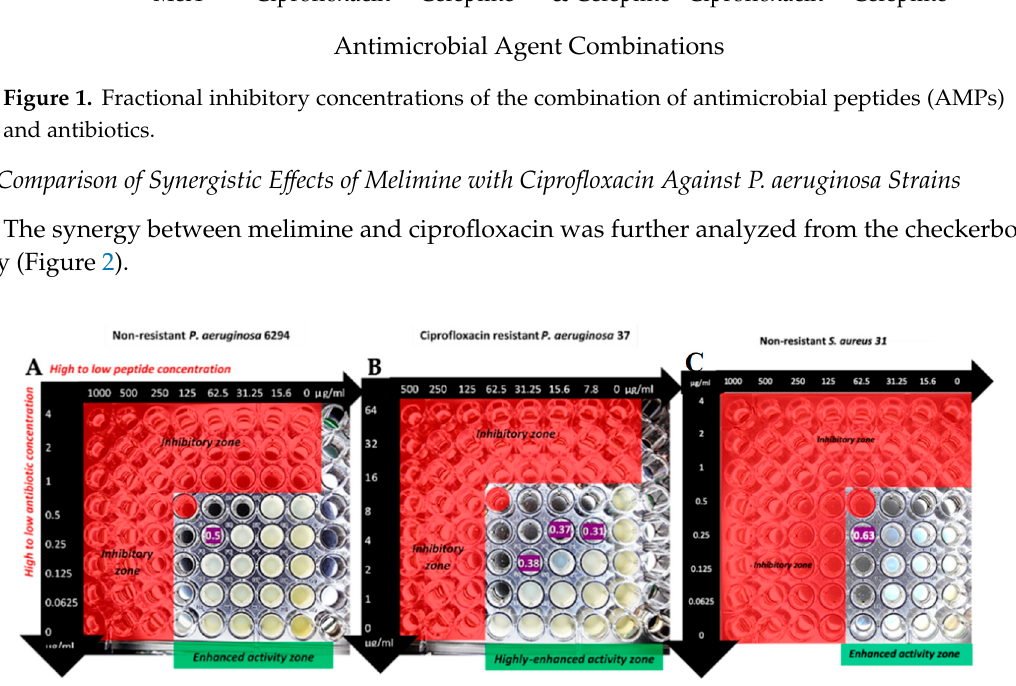
Figure 2. Results of checkerboard assay of the combination of melimine and ciprofloxacin with P. aeruginosa 6294 ( A ), P. aeruginosa 37 ( B ) and S. aureus 31 ( C ). Fractional inhibitory concentration (FICs) values are shown in purple. The red zones demonstrate the inhibitory zones based on the minimum inhibitory concentration (MIC) results.